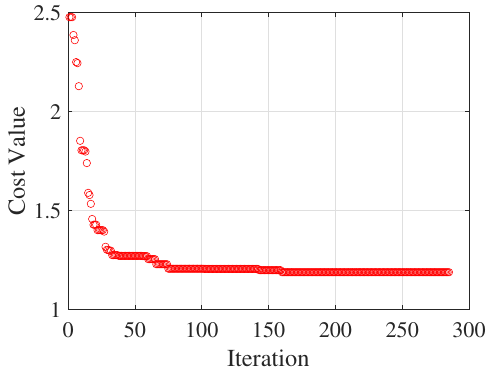
Figure 13. The best values of cost function in case